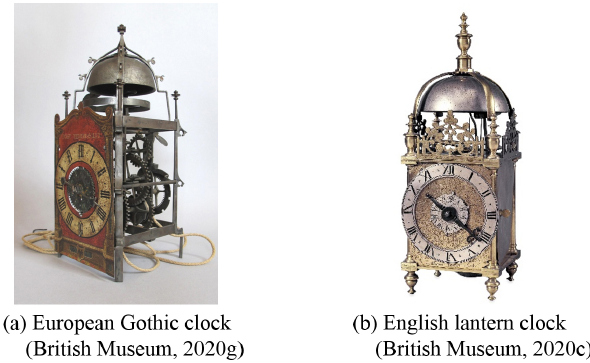
Figure 1. Chamber clocks.